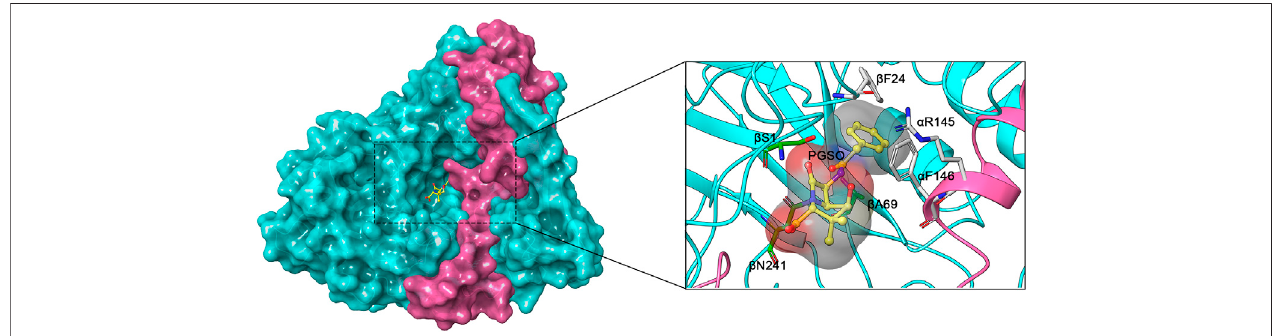
FIGURE 4 | Crystal structure of EcPGA with ligand penicillin G sulfoxide (PGSO) (yellow) (PDB ID: 1GM9). The α and β subunits are coloured fuchsia and cyan, respectively. The active sites β S1, β A69, and β N241 are coloured green and good mutation sites α R145, α F146, and β F24 are coloured light grey.